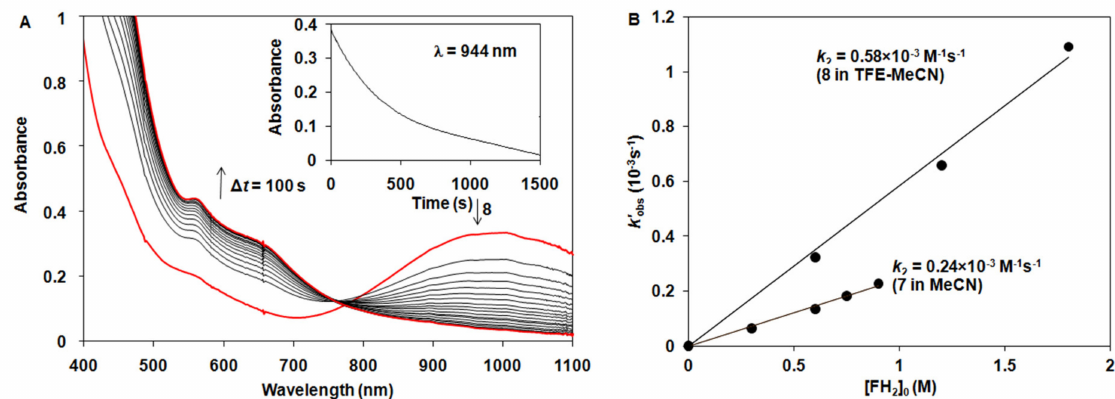
Figure 9. ( A ) UV-Vis spectral changes of 8 (2 mM, red line) upon addition of flavanone (1.8 M) in CH 3 CN/TFE at 25 ◦ C. The inset shows the time nd course of the decay of 8 monitored at 944 nm. ( B ) Determination and comparison of second-order rate constants by plotting k obs values against flavanone concentration for complexes 7 and 8 in CH 3 CN and CH 3 CN/TFE at 25 ◦ C, [M] 0 = 2